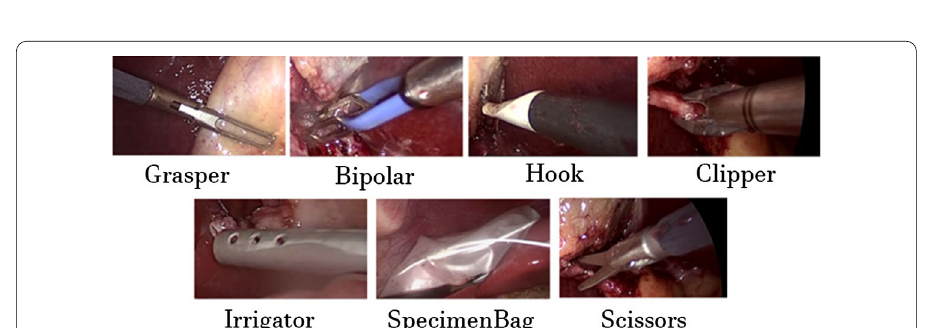
Fig. 9 Seven surgical tools present in Cholec80